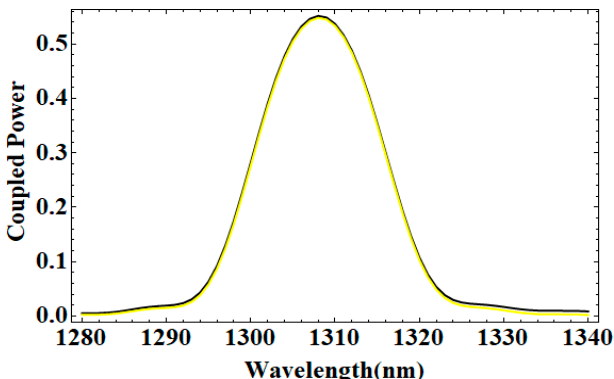
Figure 7. Combined coupled power plots using the direct method (shown in yellow) and the indirect method (shown in black) as a function of wavelength .